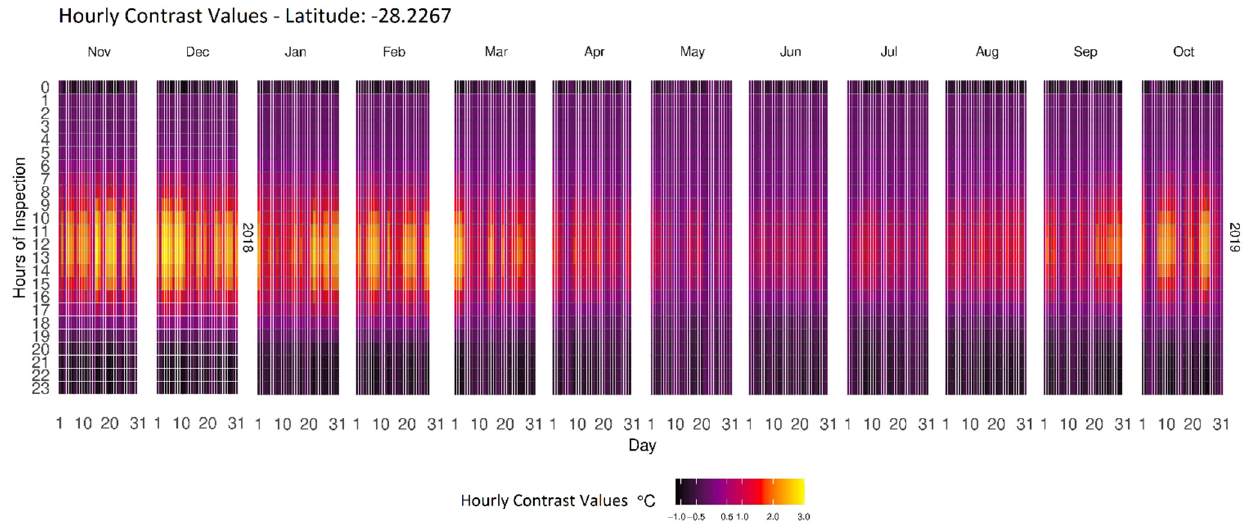
Figure 8. Heatmap of contrast values (C ◦ ) through the entire year of FEM simulation to visualize the favorable periods for inspection at the latitude of